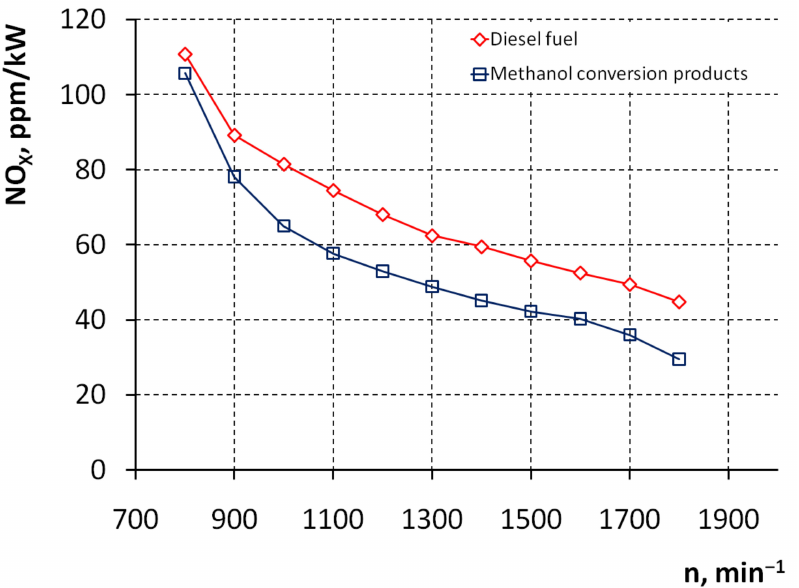
Figure 11. Experimental dependences of the content of nitrogen oxides in exhaust gases on the crankshaft speed of the engine n for different motor